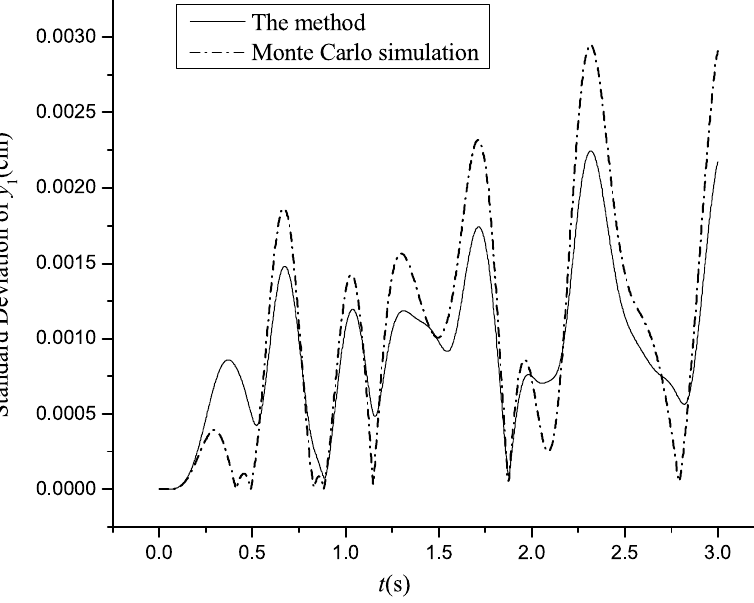
Fig. 4. The standard deviation curve of the displacement y 1